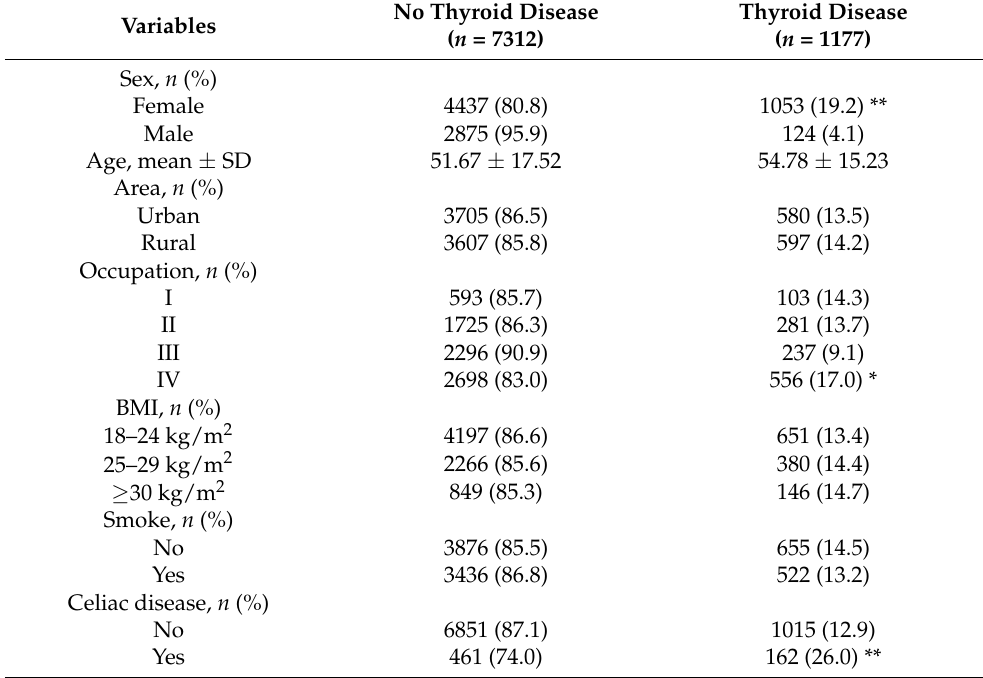
Table 1. Descriptive statistics in 8489 study participants according to thyroid